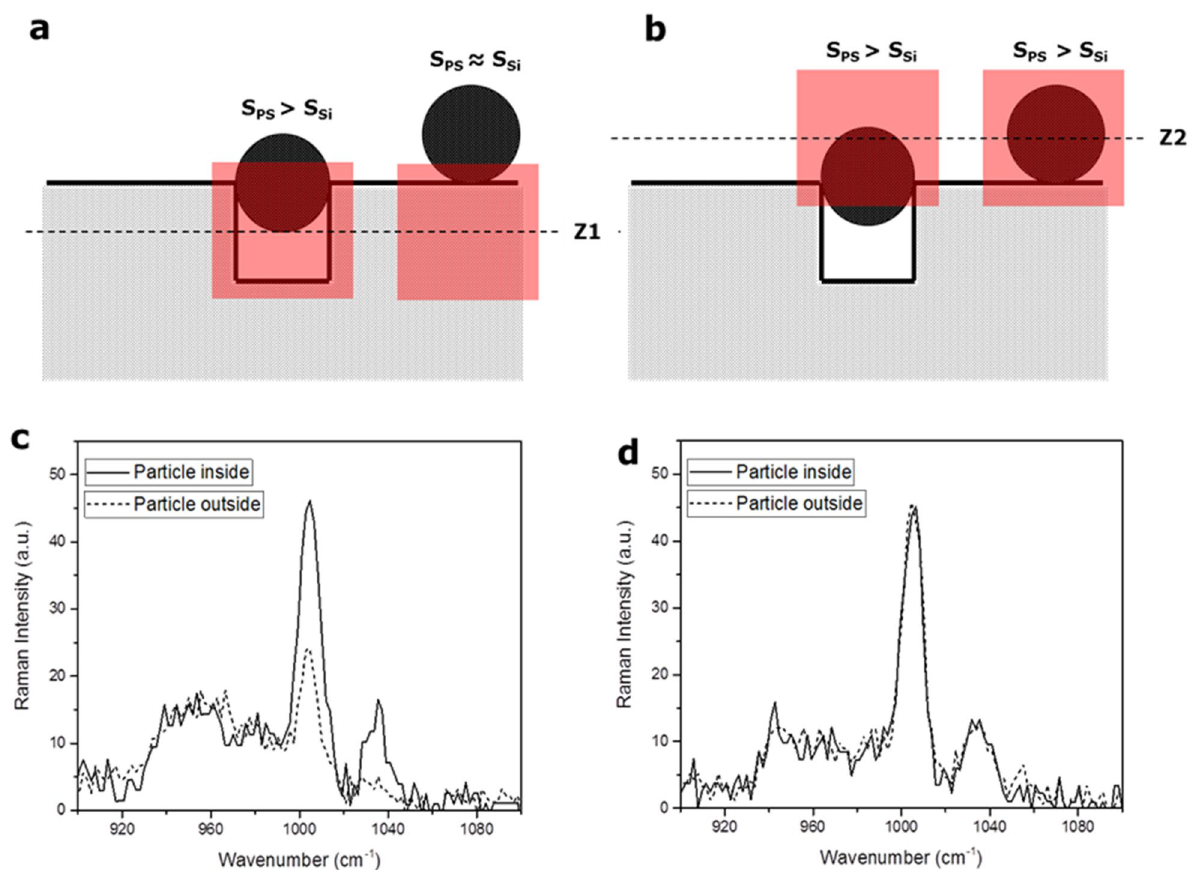
Figure 2. ( a ) Detection principle of the size-exclusion Raman microscopy with focus at the level underneath the silicon surface ( b ) Detection principle of the size-exclusion Raman microscopy with focus at the level